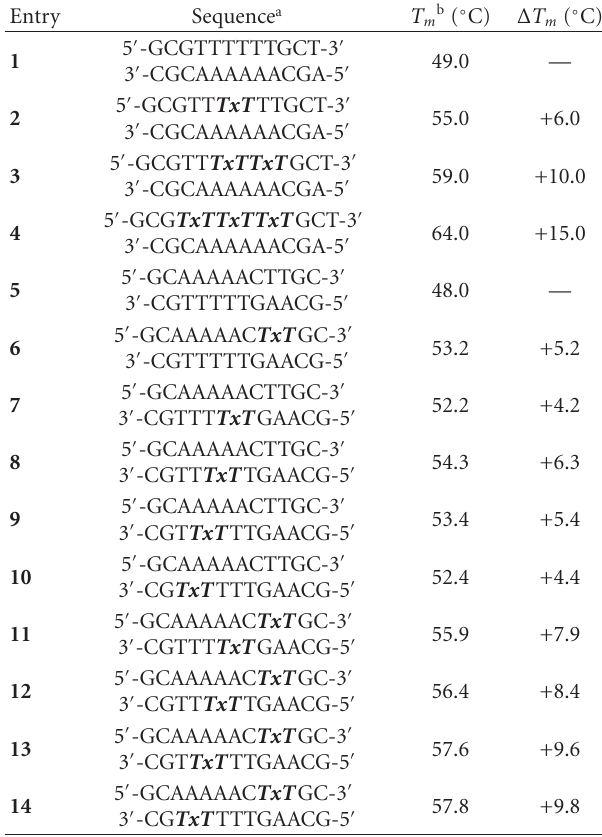
Table 2: Sequences and melting temperatures of CNAgm contain- ing